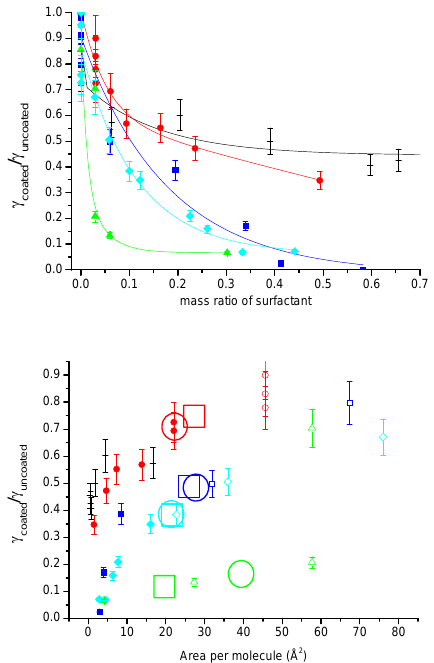
Fig. 5. (a) Ratio of the uptake coefficient for coated particles to that for uncoated particles ( γ coated /γ uncoated ) containing dry mass ra- tios of 0–70% of surfactant for different fatty acids (black crosses: C 9 , red circles: C 12 , green triangles: C 15 , blue squares: C 18 and turquoise diamonds: C 20 ). The lines are only guides to the eye. (b) Ratio γ coated /γ uncoated as a function of the area per molecule of surfactant (black crosses: C 9 , red circles: C 12 , green triangles: C 15 , blue squares: C 18 and turquoise diamonds: C 20 ). The rect- angles represent the position of the equilibrium spreading pressure ESP and the circles represent the phase transition film pressure Fj. For each fatty acid, the open symbols denote data points, where the monolayer has a density smaller than expected at ESP, while plain symbols denote datapoints beyond the ESP, where the additional fatty acid mass was remaining as a separate bulk